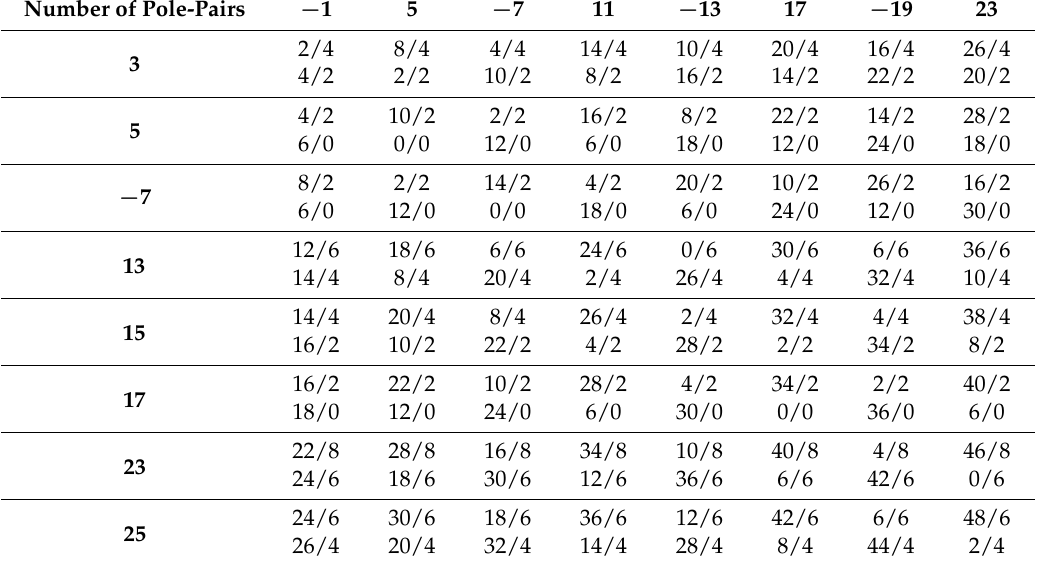
Table 5. The radial electromagnetic force in the air gap produced by the interaction between the permanent magnetic field and the armature reaction magnetic field (mode number/frequency times). Number of Pole-Pairs